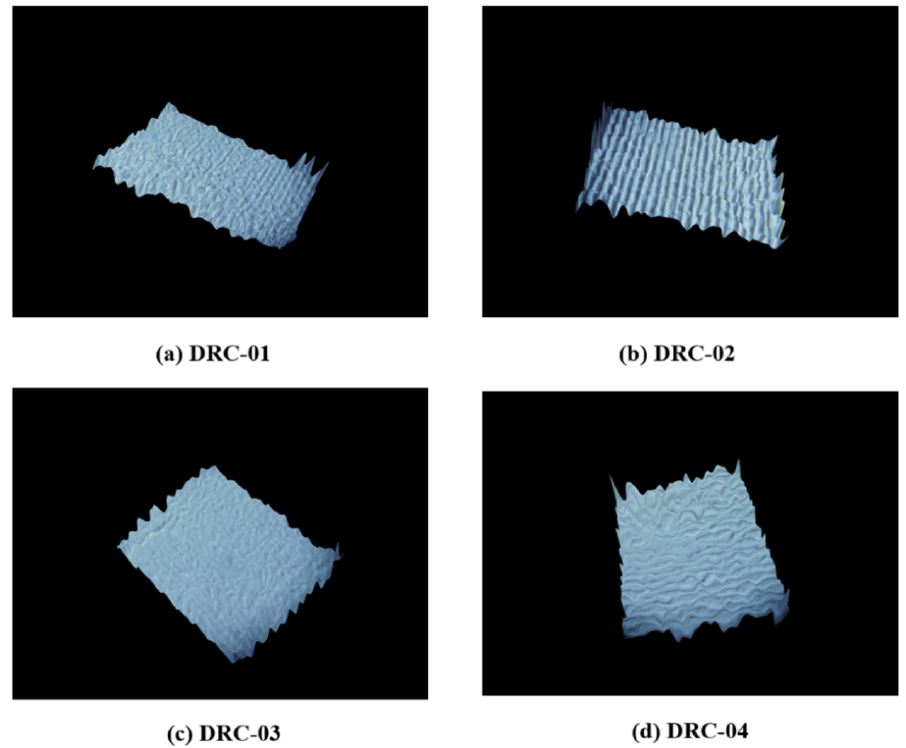
Figure 6. Three-dimensional structure of microgroove polyurethane coatings.